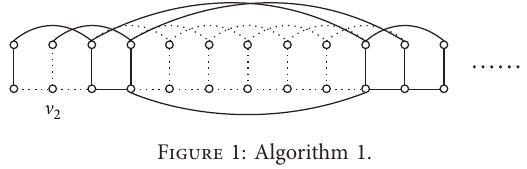
Figure 1: Algorithm